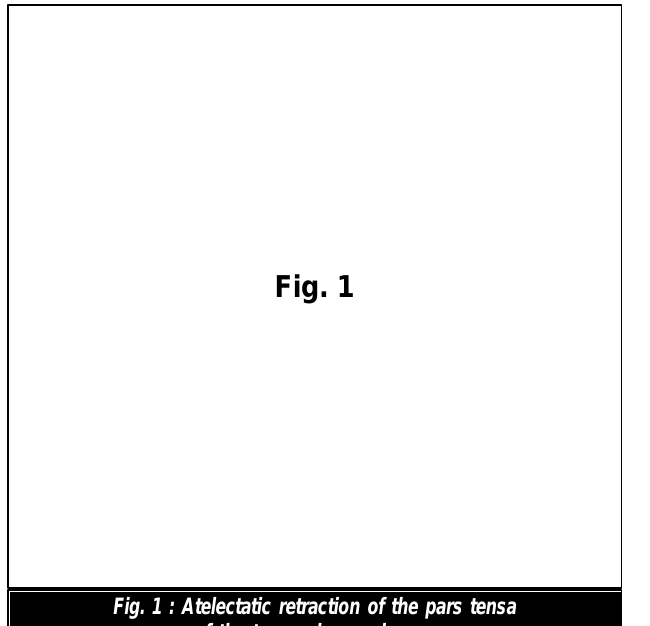
Fig. 1 : Atelectatic retraction of the pars tensa of the tympanic